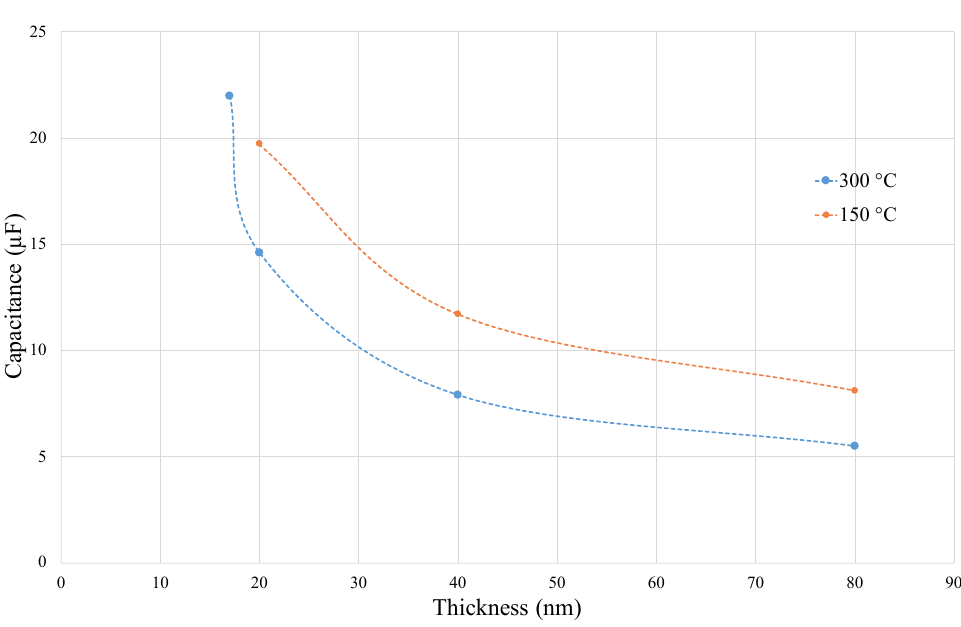
Figure 5. Capacitance value of the TiO 2 samples over thickness deposited in two different temperatures.